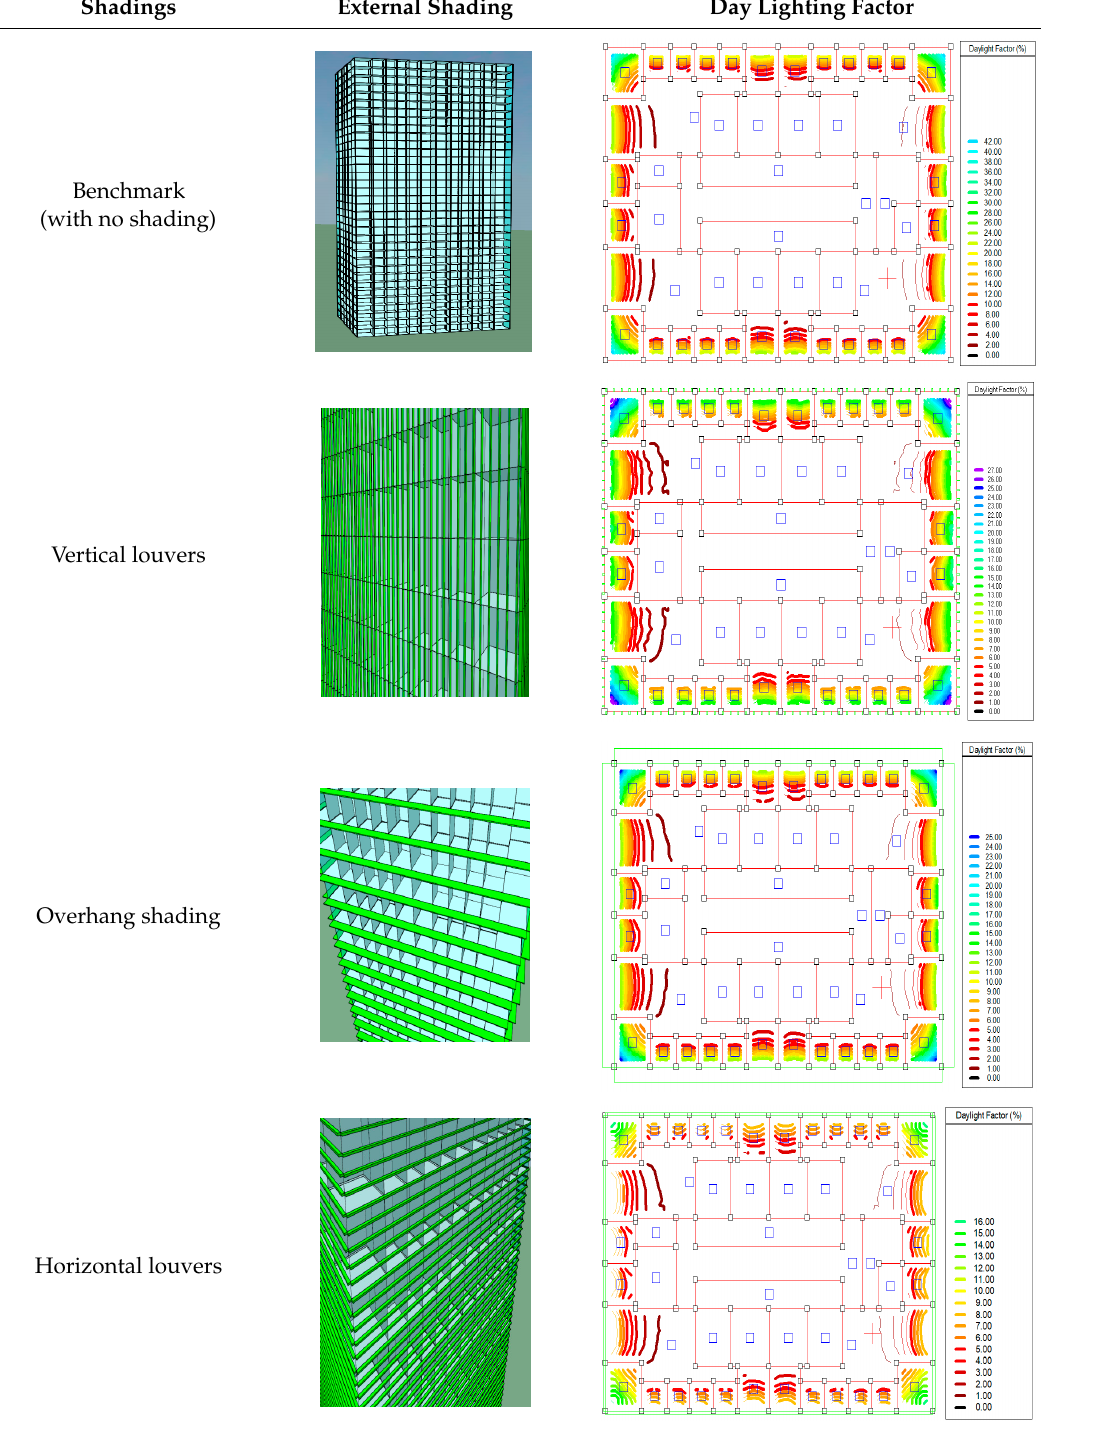
Table 13. Daylight factor of the external and internal shadings.